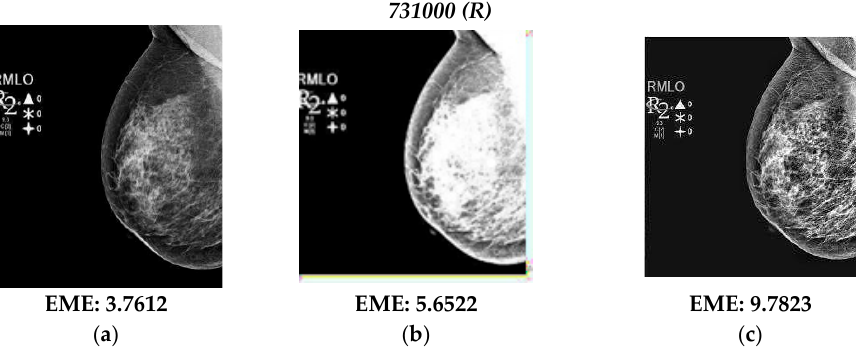
Figure 2. ( a ) Original Breast Images (Mammograms/tomograms); enhancement results obtained us- ing ( b ) S-curve Transformation Function; ( c ) Optimized S-curve Transformation Function (Pro- posed).